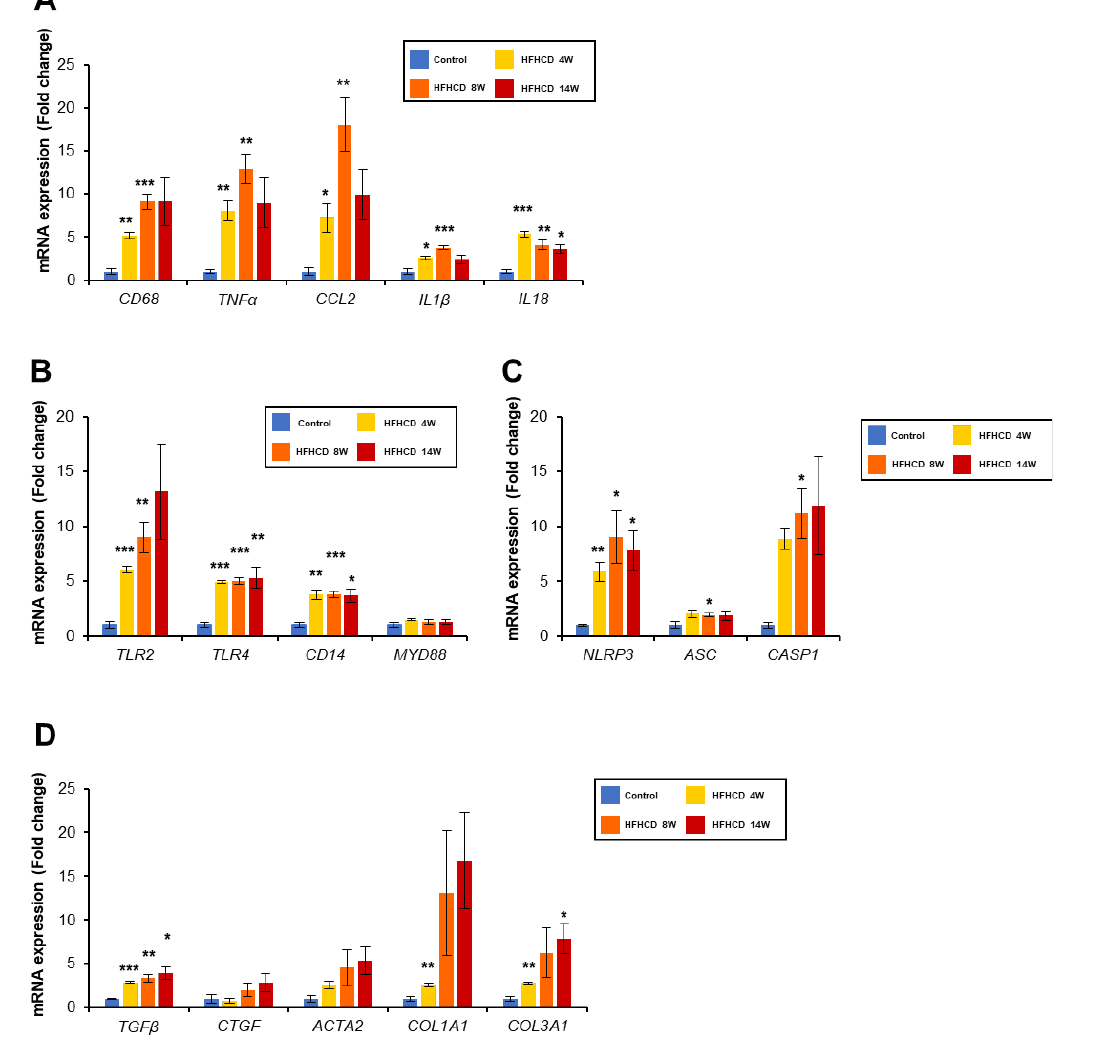
Figure 5. HFHCD increased the inflammatory and fibrogenic genes. Hepatic mRNA levels of genes related to inflammation ( A ), TLRs ( B ), NLRP3 inflammasome ( C ), and fibrosis (D) were quantified via real-time PCR and normalized to GAPDH. Data are shown as the mean ± SEM. * p < 0.05, ** p < 0.01, and *** p < 0.001 vs. control group. Control group (12 weeks, n = 3), HFHCD group; 4 weeks (n = 3), 8 weeks (n = 4), 14 weeks (n = 4).